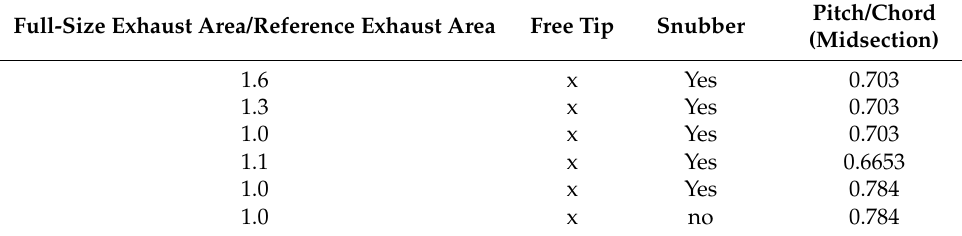
Table 1. Experimental setup of low-pressure turbine rear stages and diffuser. Full-Size Exhaust Area/Reference Exhaust Area